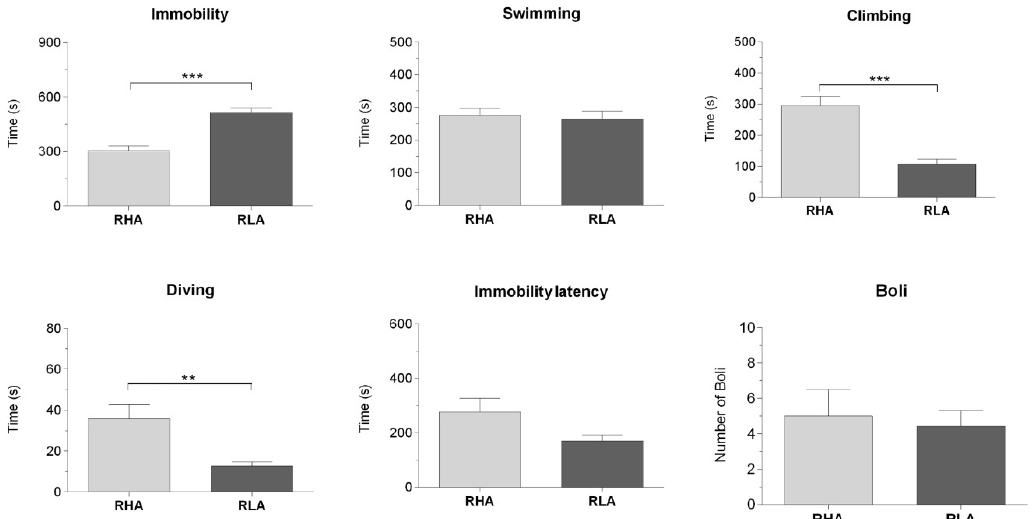
Figure 1. Behavioral performance of the Roman High-Avoidance (RHA) and the Roman Low-Avoidance (RLA) rats, during the 15 min forced swimming session. The columns and bars represent the mean ± SEM ( N = 7 rats in each experimental group). ** p < 0.01, *** p < 0.001 (Student’s t test for independent samples).